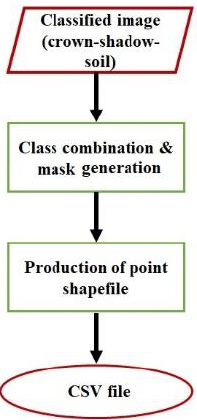
Figure 3. Flow chart of automatic extraction of soil information from drone data.